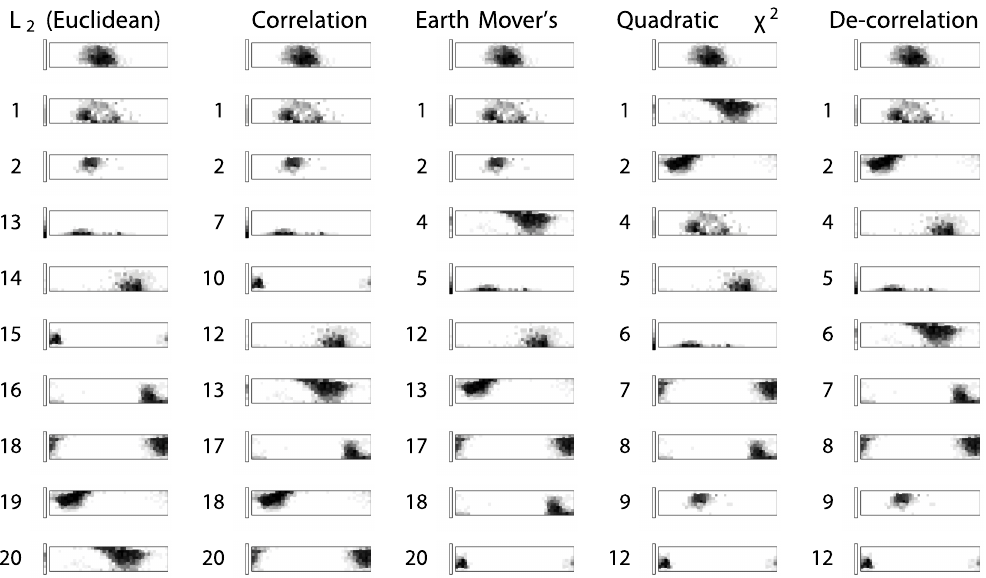
Figure 3. A selection of high-response rate Amuzgo color words ranked by different metrics by their distance from cachii . Ther permutation invariance of the metric used by Lindsey & Brown is visible in how the yellow/green immediate neighbour to cachii is placed 3rd most remote; while purple and disjoint red/brown and dark blue are placed far closer. The Amuzgo color words, as ranked by the L 2 metric are on the far left. One might expect that neighboring color words should rank high in a metric that accurately compares distributions of color naming responses; however we can notice that the basic color words immediately neighboring cachii at the top left come last in the ranking.